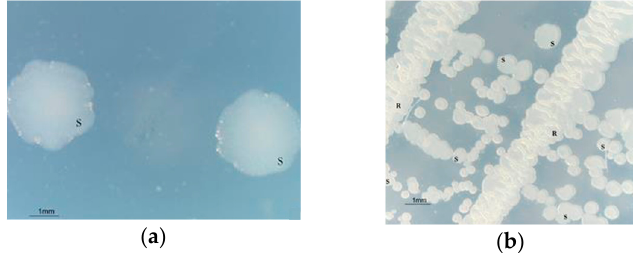
Figure 1. Pseudomonas spp. 4A strain colonial dissociation in LB-agar plates. ( a ) Smooth colonies (S), and ( b ) a mixture of Rough (R) and Smooth colonies